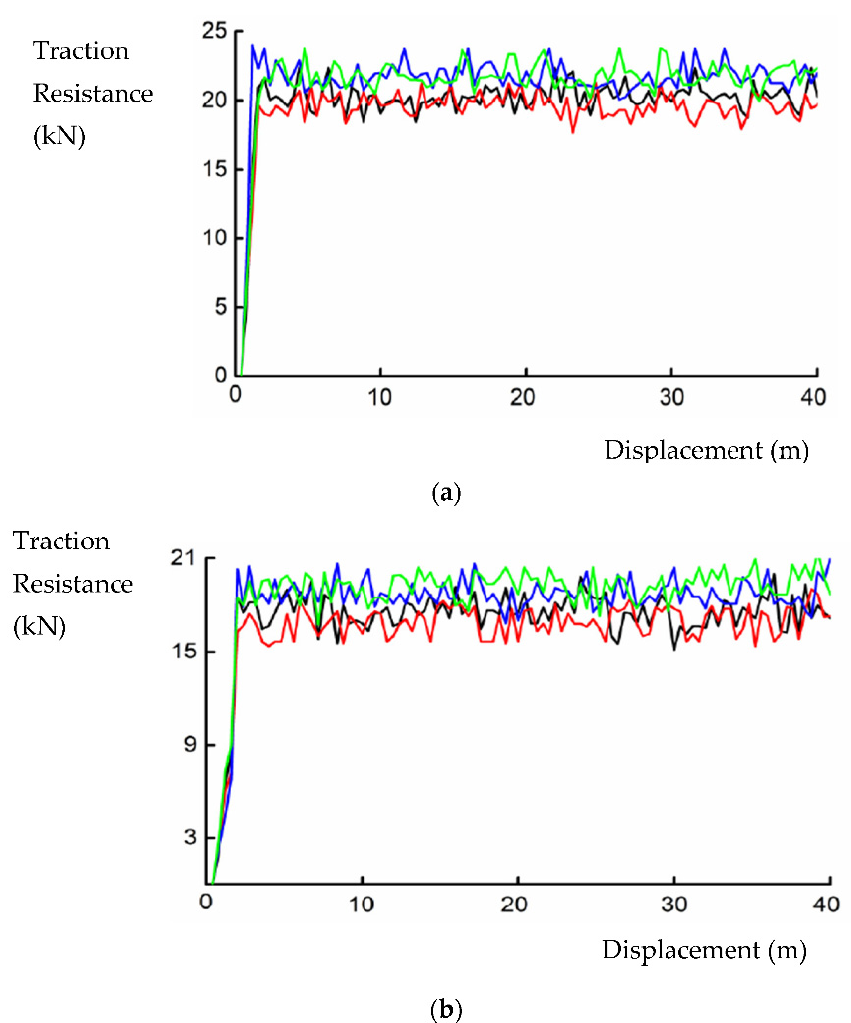
Figure 8. Traction resistance–displacement diagram of deep loose shovel at 15 cm tillage depth (the angle θ = 25 ◦ between the ditching plough and the ground plane). ( a ) Forward speed (0.9 m/s). ( b ) Forward speed (1.5